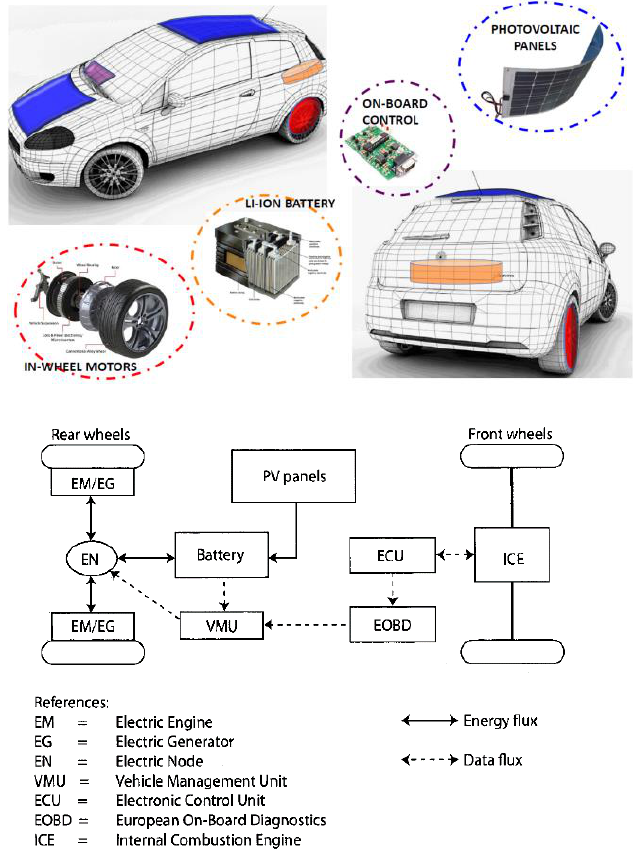
Figure 2. Schematic depiction of the solar hybridization kit. (Source [21]).